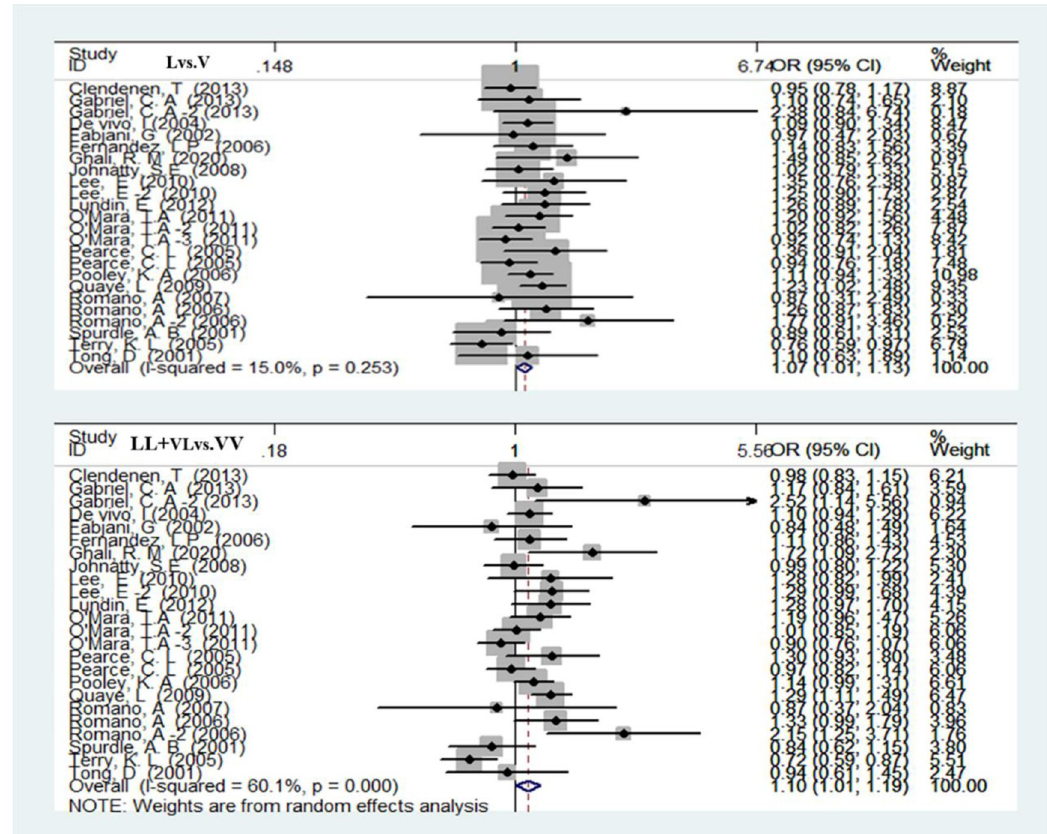
Fig 3. Forest plot of overall cancer risk associated with V660L PgR polymorphism (L vs. V and LL+VL vs.